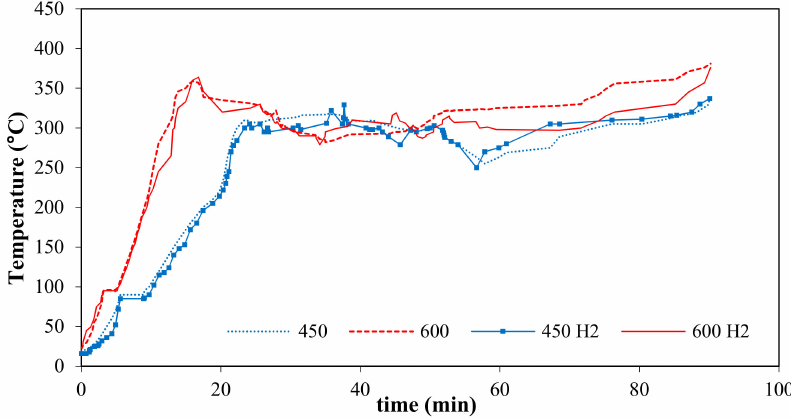
Figure 2. Thermographs measured inside of the reactor with and without flow of